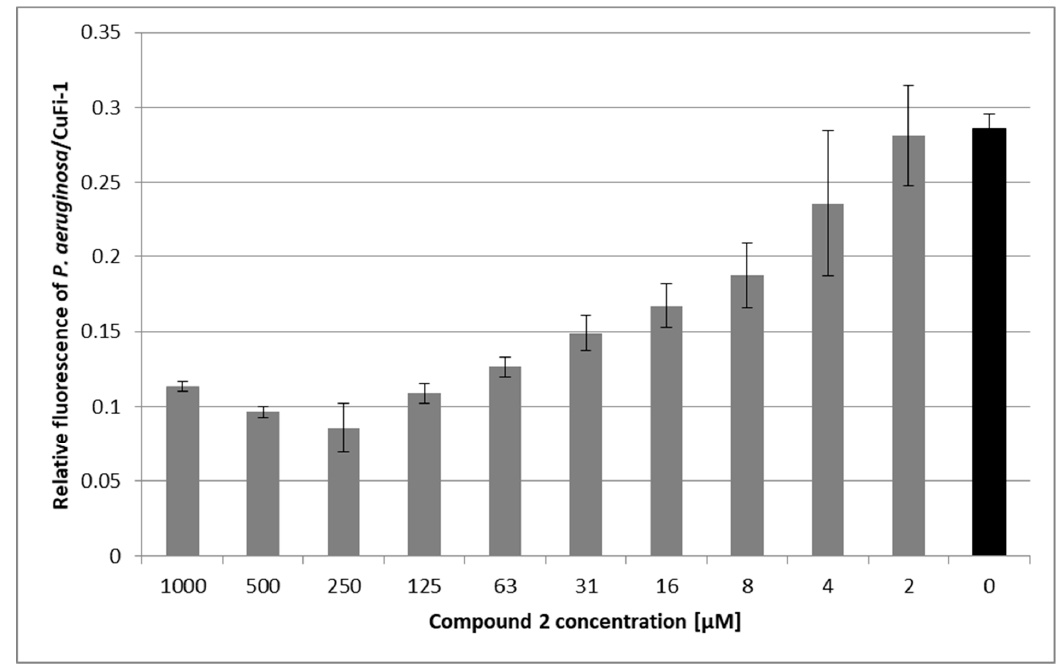
Figure 3. P. aeruginosa adhesion to human bronchial epithelial cells (CuFi-1) in the presence of compound 2 . Monolayers of CuFi-1 cells stained with PKH67 were exposed to suspensions containing P. aeruginosa stained with PKH26 and compound 2 (grey bars) or PBS (Phosphate Buffered Saline) as a control (black bar). After 2-h incubation, non-adhered bacteria were removed by washing and the relative fluorescence of adhered bacteria and epithelial cells was quantified using Tecan Infinite M200 Pro. Results are expressed as a relative fluorescence ratio of P. aeruginosa /CuFi-1 plotted as a function of compound 2 ’s concentration. Plotted data are means ± SD of three independent incubations.